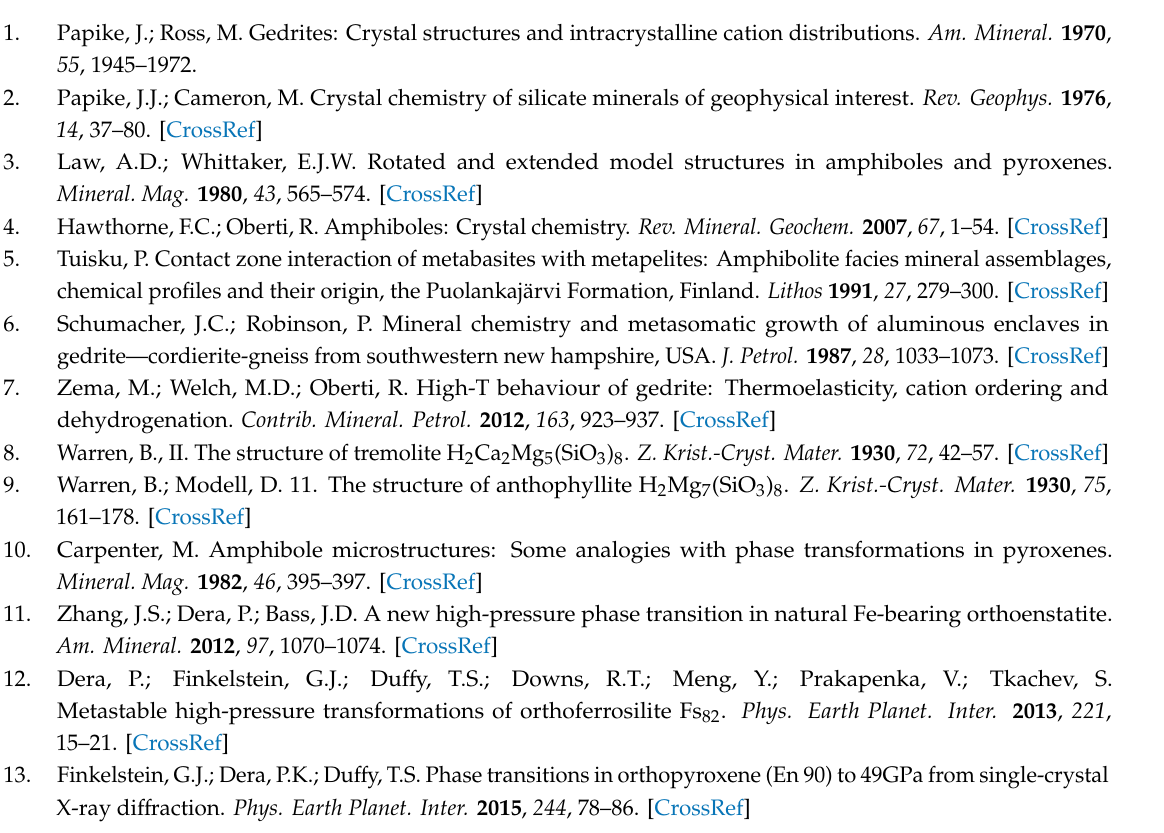
Table S1. Hydrogen-bond and intermolecular contact interaction geometry; Table S2. Refined fractional atomic coordinates and isotropic displacement parameters for gedrite at selected pressures; Table S3. Anisotropic displacement parameters for gedrite at ambient